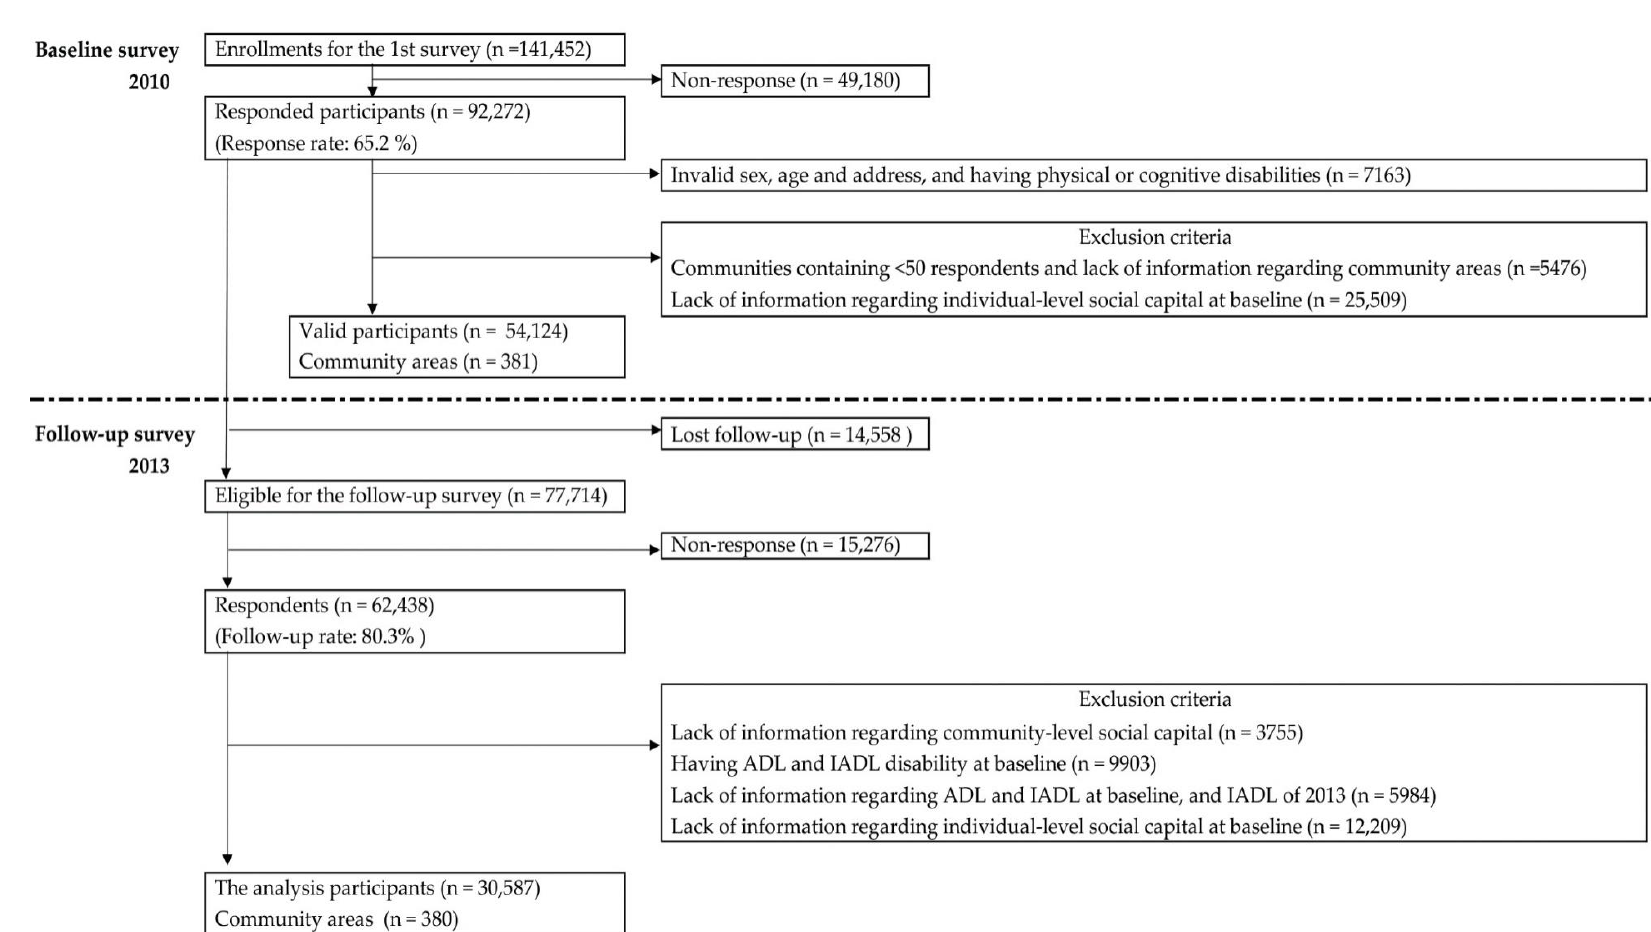
Figure 1. Flow chart showing participation in surveys of 2010 and 2013.